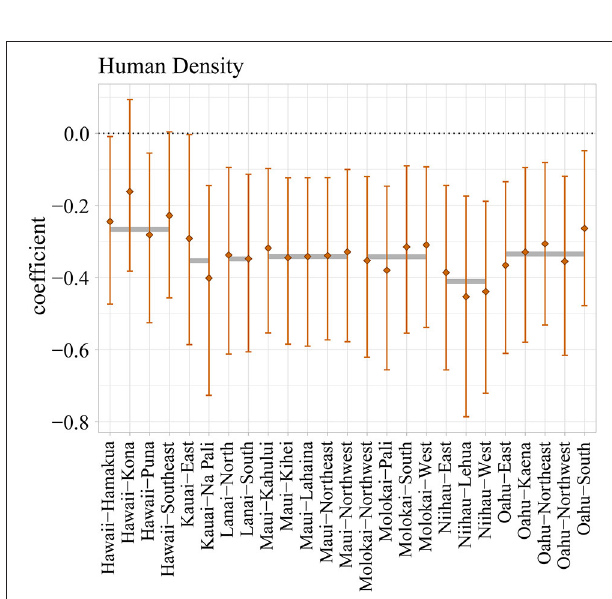
FIGURE 6 | Sector-level effect (vertical whiskers) of human density on total reef fish log biomass in our hierarchical model for the main Hawaiian Islands. The mean (diamond) effect and 66% Bayesian Credible Intervals (whiskers) are shown for each sector. Island-level mean effects are also shown (gray horizontal bars).